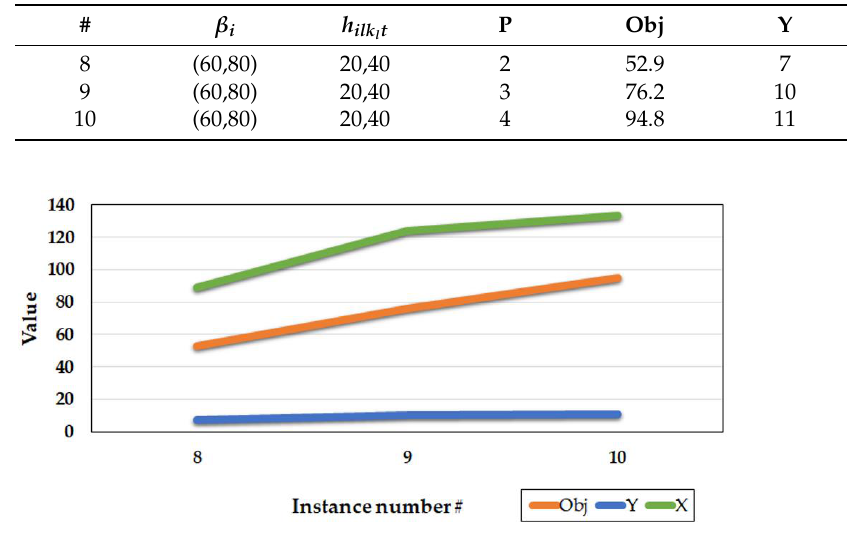
Figure 3. Results of the sensitivity analysis for the number of the facilities.